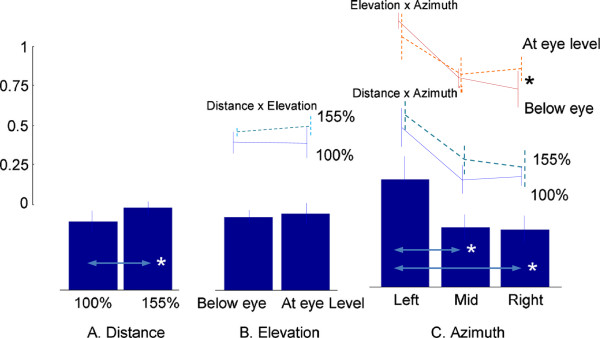
Proportion of torso movement contribution allocated to the MS (torso flexion/extension). Values on the y-axis are in a [0,1] scale and unitless (as defined in Equation 6). A value > 0.5 indicates that a larger torso movement contribution is allocated to the MS than the VS. *denotes a statistically significant difference at p < 0.05. A: Distance, B: Elevation, and C: Azimuth effects.